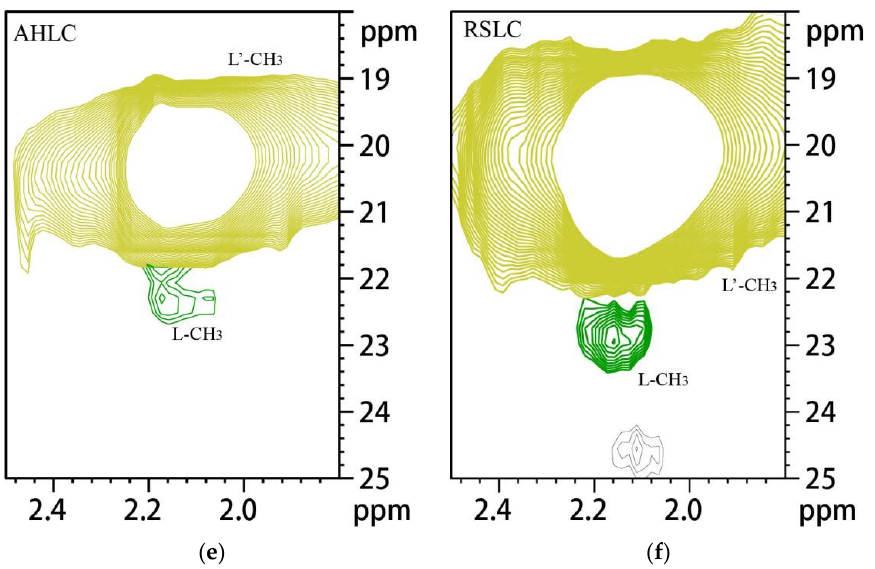
Figure 6. The 2D-HSQC NMR spectra of AHLC and RSLC: ( a ) The spectra of the AHLC side-chain region; ( b ) The spectra of the RSLC side-chain region; ( c ) The spectra of the AHLC aromatic region; ( d ) The spectra of the RSLC aromatic region; ( e ) The spectra of the AHLC aliphatic region; ( f ) The spectra of the RSLC aliphatic region.